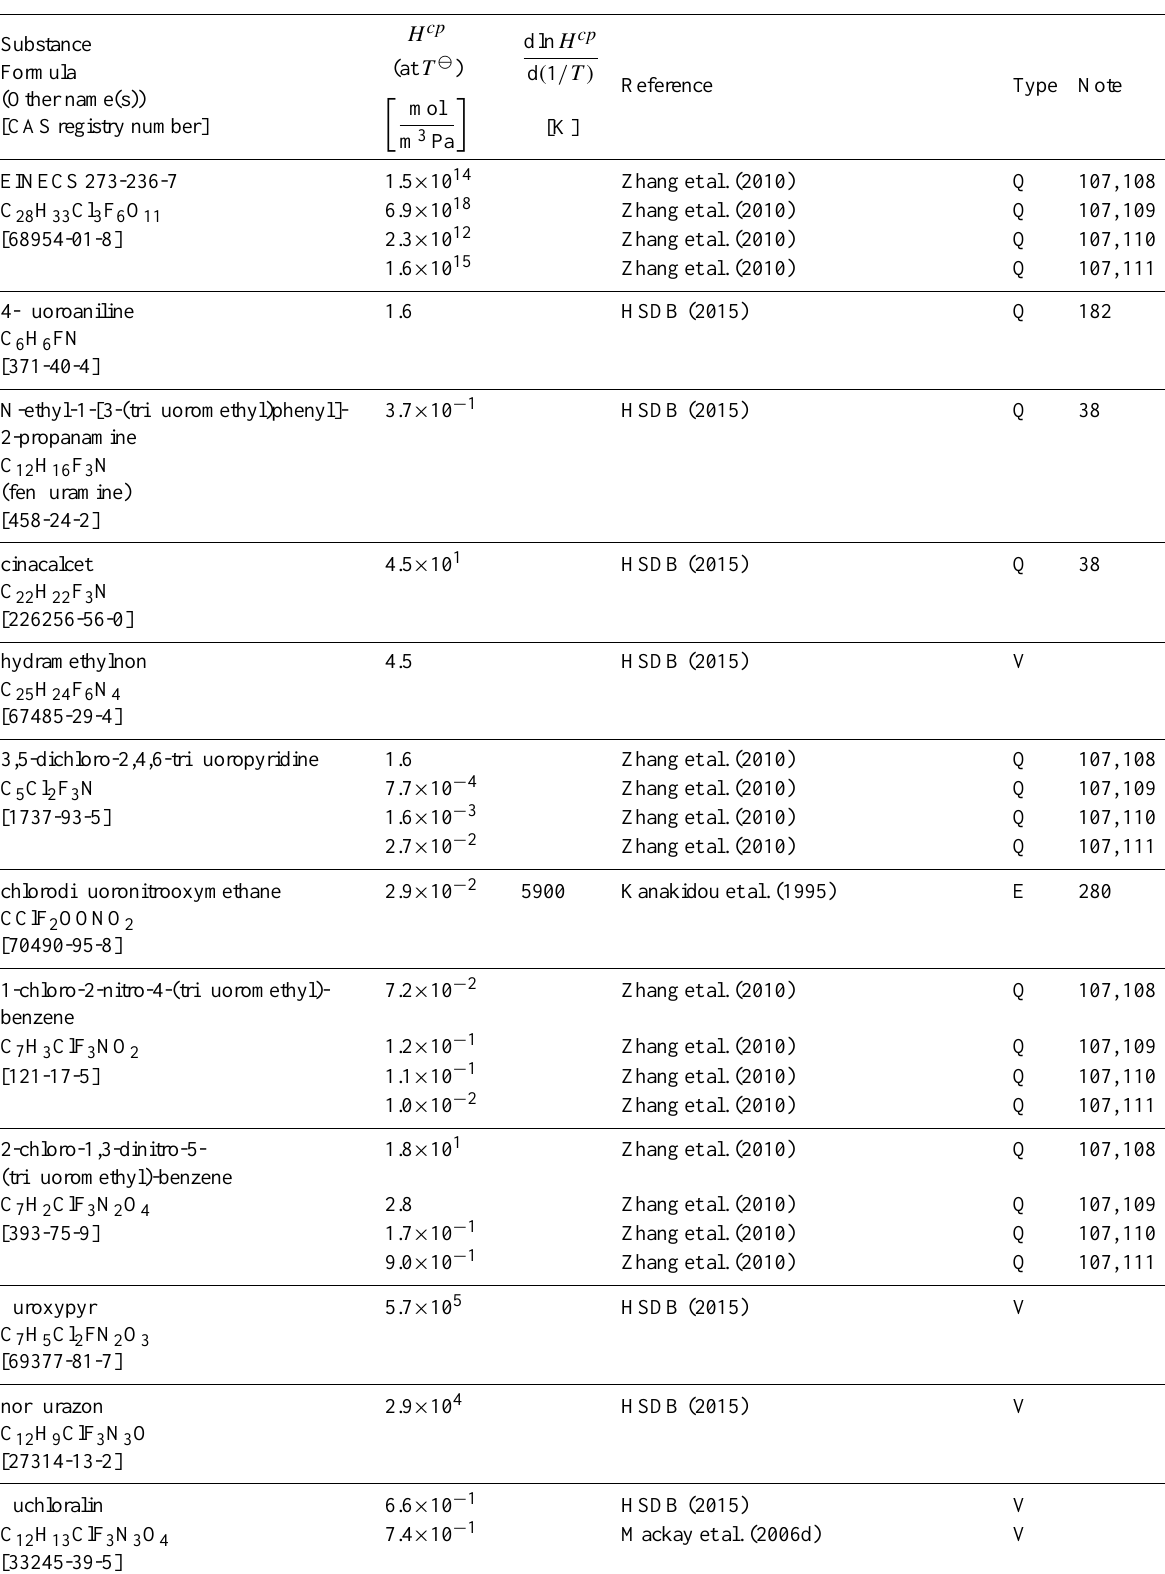
Table 6: Henry’s law constants for water as solvent